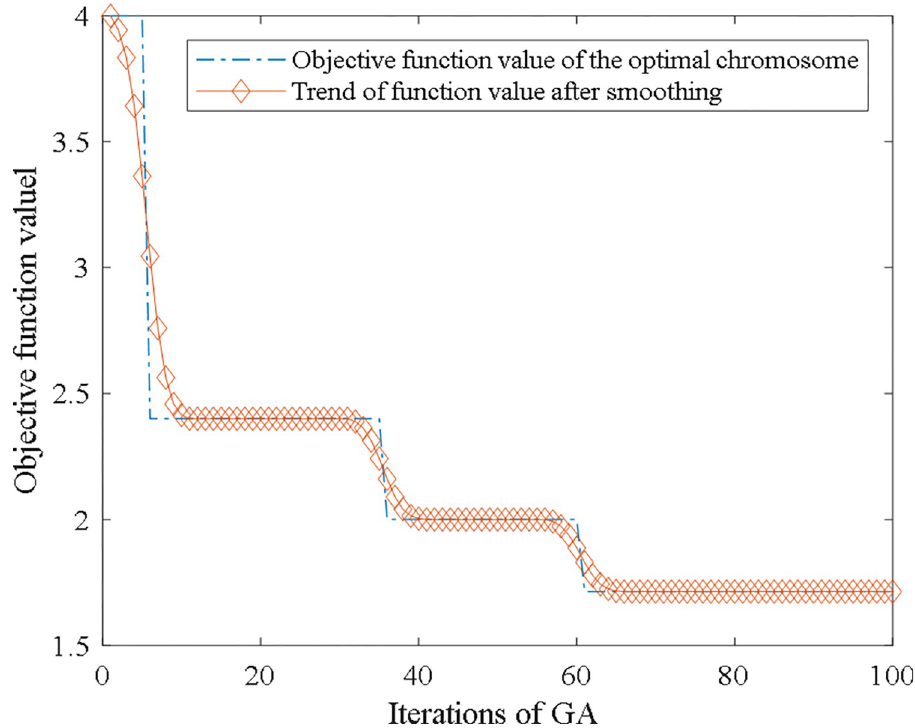
Fig 11. The convergence curve of the objective function.